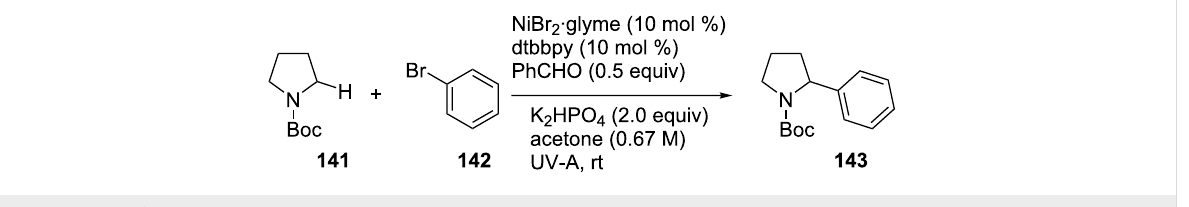
oylpyrrolidines ( 144f ), for which the yields dropped consider- ably. The alkylation of the pyrrolidine 141 was also possible employing a variety of alkyl bromides, including cyclic and acyclic secondary alkyl bromides as well as alkyl bromides carrying functional groups such as organosilyl and boronate moieties. However, the solvent had to be changed from acetone to acetonitrile in order to achieve good yields of 145h – l (Scheme 32). Additionally, products derived from ureas (i.e., 146 ), N , N -dimethylaniline (i.e., 147 ), amides (i.e., 148 ), and lactams (i.e., 149a ) were obtained. Moreover, for N -methyl- pyrrolidinone, α -arylation was achieved in a good yield and regioselectivity for the substitution of the 2-position, yielding 149a , rather than for the N -methyl group, which would yield 149b (Scheme